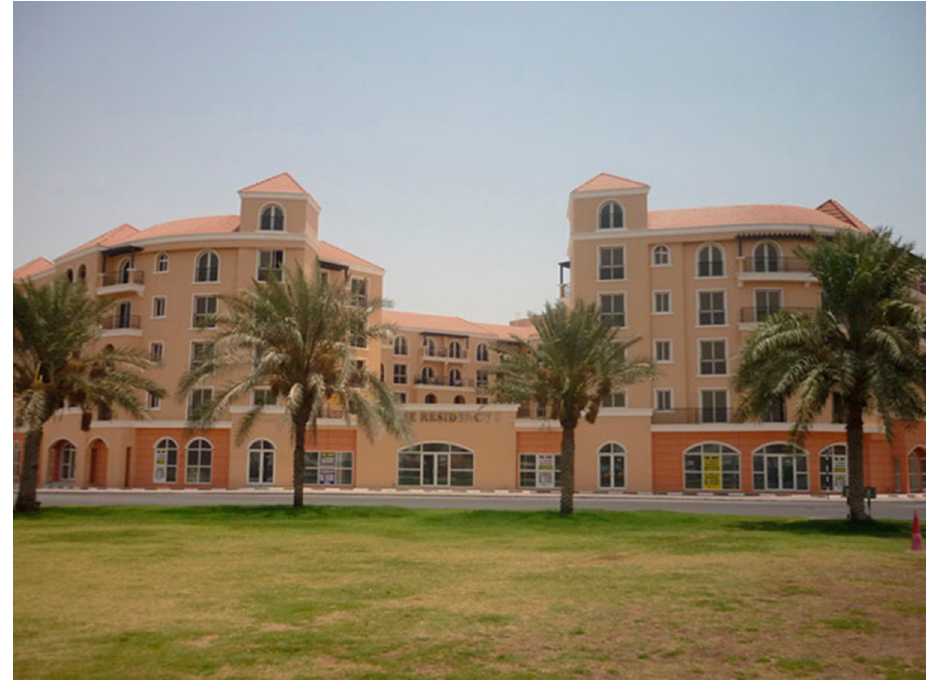
Figure 2. Prime Residency I (PR I), International City, Dubai, UAE.